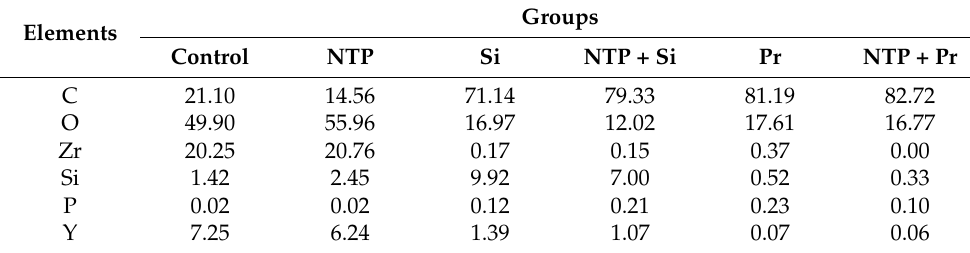
Figure 8. Survey XPS spectra for the zirconia blocks before and after NTP treatment. ( a ) Control group. ( b ) NTP group. ( c ) Si group. ( d ) NTP + Si group. ( e ) Pr group. ( f ) NTP + Pr group. Table 3. Surface chemistry composition of zirconia blocks (in atomic percentage) for each group.